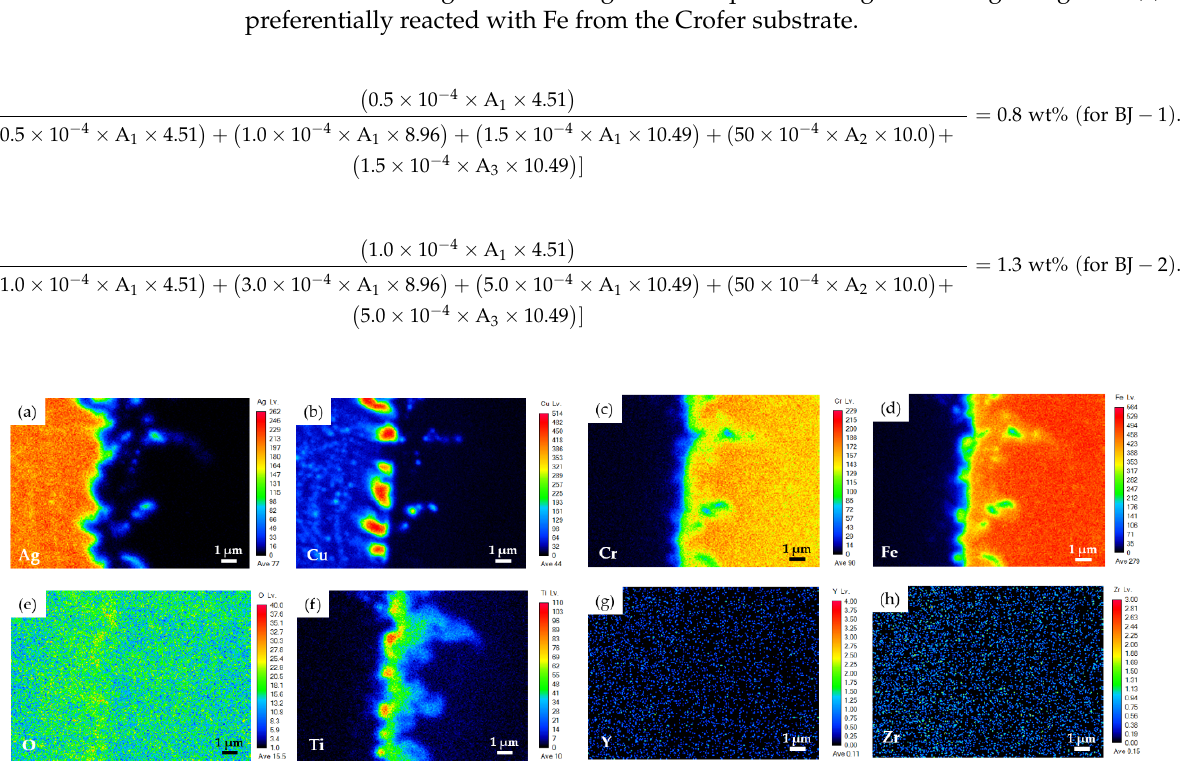
Figure 8. EPMA WDS element mappings of the Crofer side in Figure 6d: ( a ) Ag, ( b ) Cu, ( c ) Cr, ( d ) Fe, ( e ) O, ( f ) Ti, ( g ) Y, and ( h ) Zr.